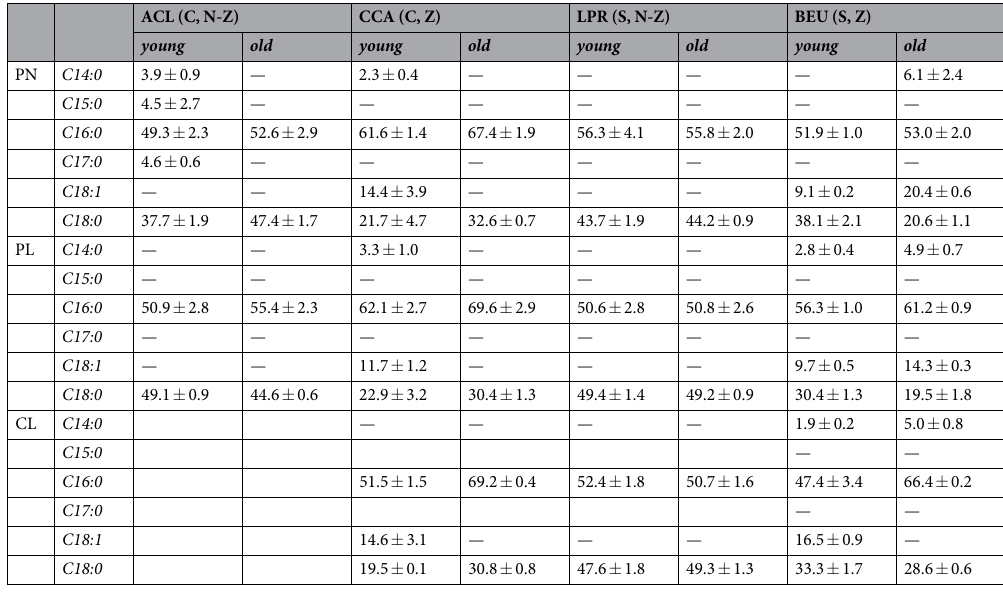
Table 3. Composition (relative distribution %) of the fatty acids extracted from A . calycularis (ACL), C . caespitosa (CCA), L . pruvoti (LPR) and B . europaea (BEU) skeletons collected along a latitudinal gradient of temperature in the Tyrrhenian Sea in Pantelleria island (PN), Palinuro (PL) and Calafuria (CL). The concentration of detected fatty acids is reported as fraction. The FA extracted from three skeletons for each species were analyzed. Samples of ACL were not found in CL. When the sum of the percentages is not 100 some not assigned FA was present. The standard deviation is reported. C = Colonial, S = solitary, N-Z = Non- zooxanthellate, Z =